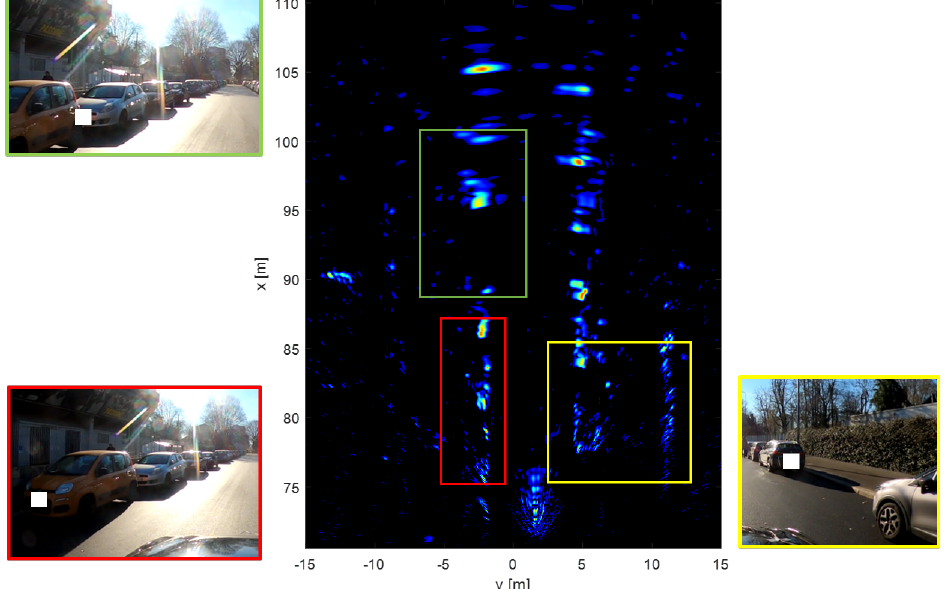
Figure 12. SAR image of the static environment with related camera snapshots. In the red box, parked cars to the left of the vehicle are clearly distinguishable. The same is valid for the cars to the right and the hedge/fence (yellow box). Almost at boresight (green box) SAR angular resolution starts to degrade, making it difficult to retrieve details of the